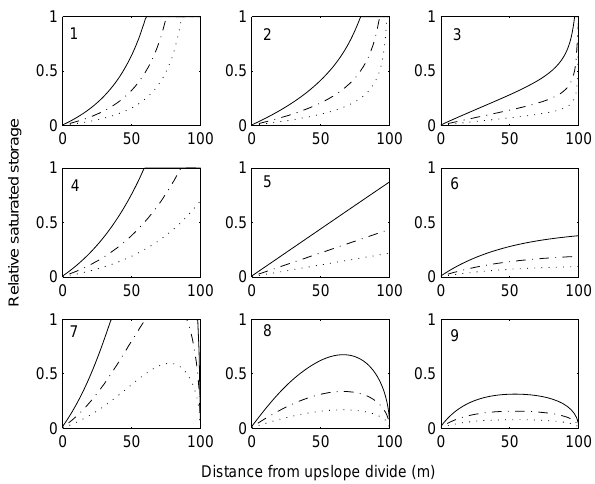
Fig. 7. Relative saturated storage along the nine basic hillslopes for different soil depths N =10mm/day (solid line: D =0.5m; dashed line: D =1m; dotted line: D =2m).